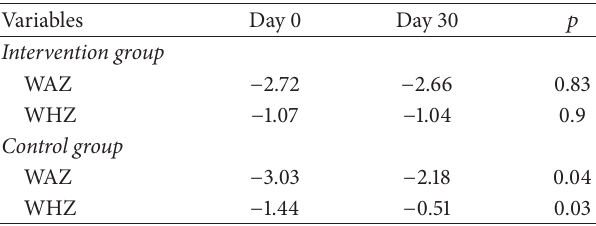
Table 2: Anthropometrics indicators of malnutrition in the study population.